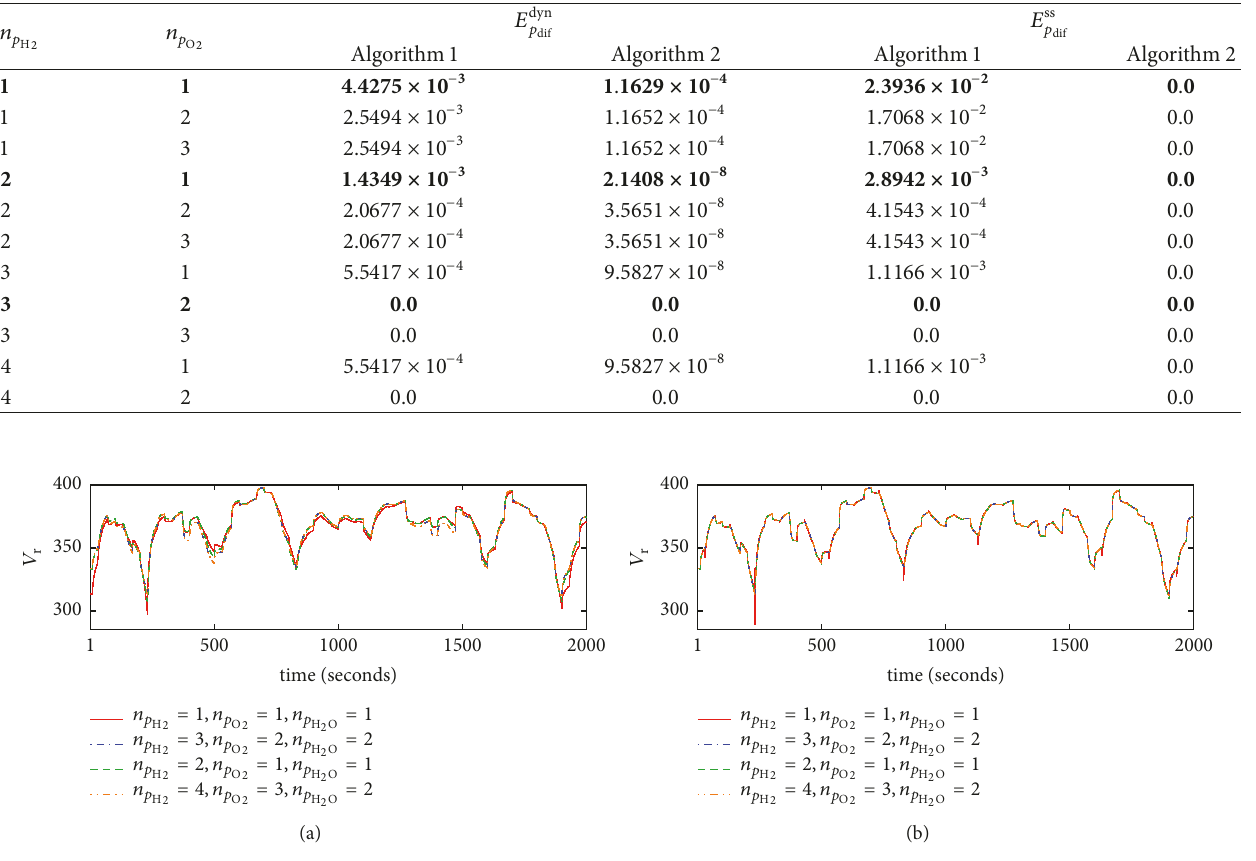
Figure 10: The voltage 𝑉 r trajectories calculated by three reduced-order and full-order ( 𝑛 𝑝 by algorithm 1 (a) and algorithm 2 (b).